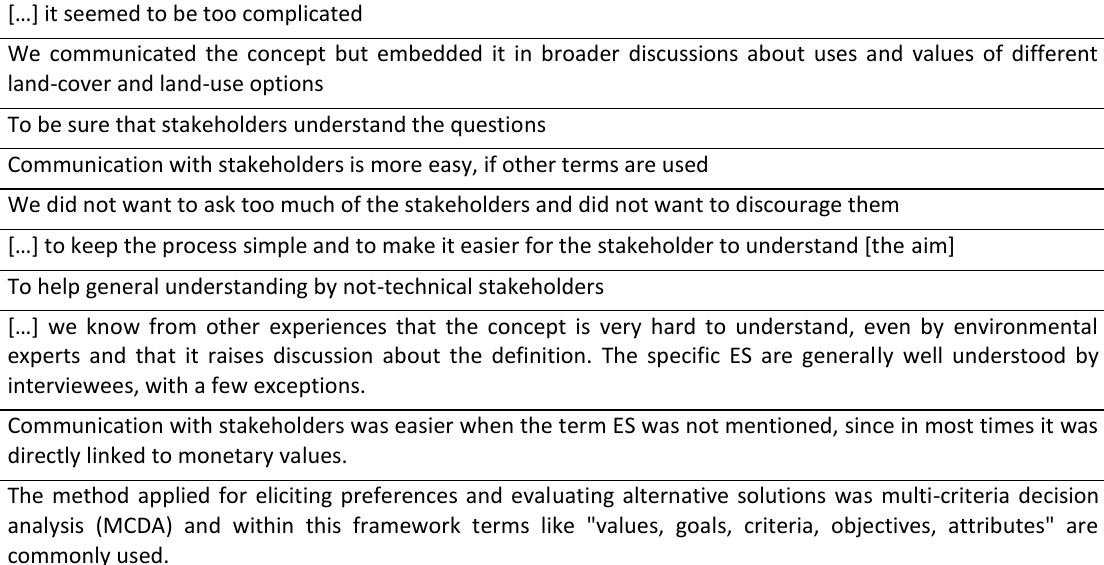
Table A2: Reasons for not (fully) explaining the ES concept to stakeholders (question